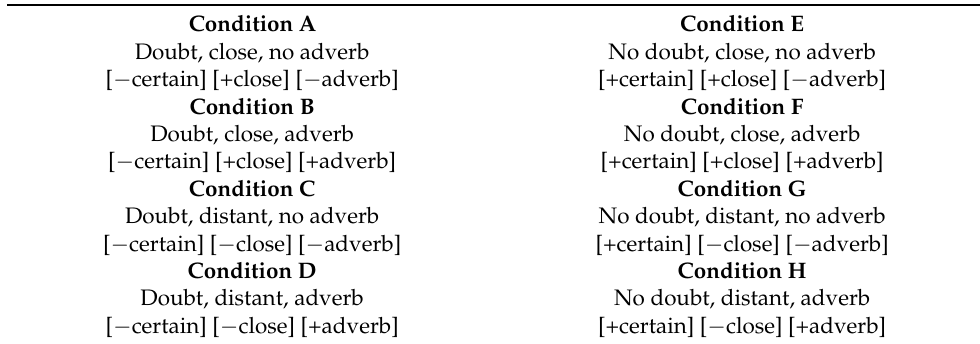
Table 2. Experimental